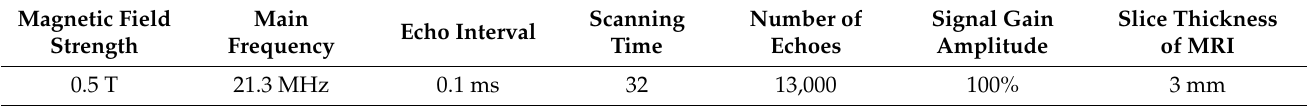
Table 1. NMR operating